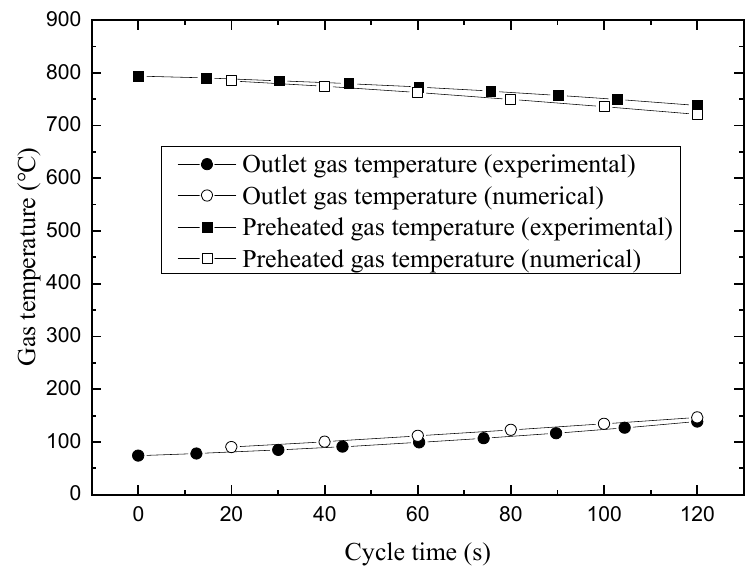
Figure 6. The temperature profile of preheated and outlet gas in a stable cycle.